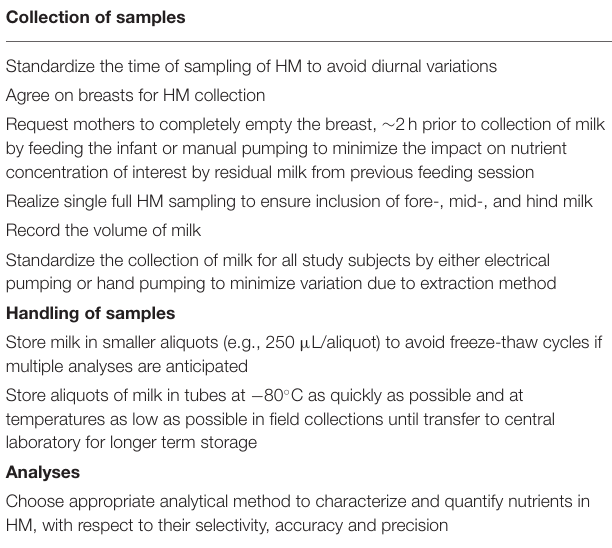
TABLE 5 | Recommendations for collecting and handling of HM